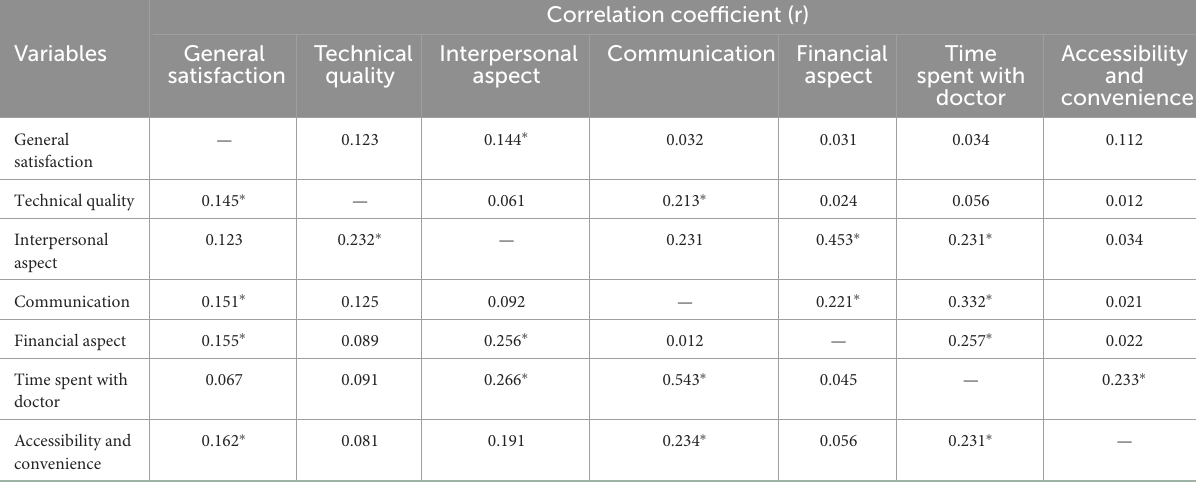
TABLE 5 Correlation between subscales of